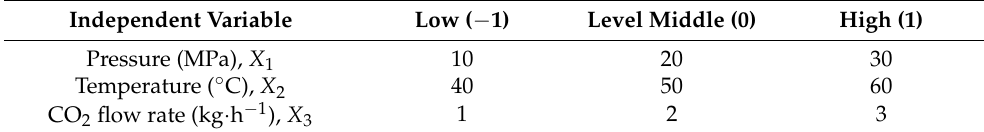
Table 6. Coded variables and their levels for the